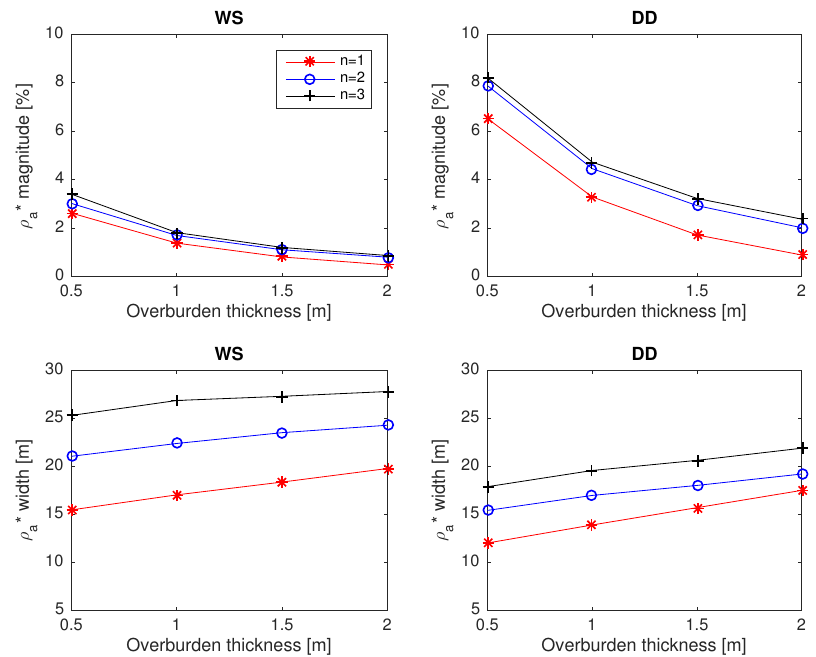
Figure 5. Apparent resistivity anomaly magnitude and width as a function of overburden thickness for the case of a single, 1-mm-aperture fracture having length (cid:96) = 5 m, electrical resistivity ρ f = 10 Ω · m, and dipping at 45 ◦ . The fracture is hosted in bedrock having resistivity ρ b = 10,000 Ω · m, whereas the overburden resistivity is ρ o = 1000 Ω · m. The measurement configuration is denoted by WS (Wenner-Schlumberger) or DD (dipole-dipole) with spacing factor n . Cases 2, 7, 8, and 9 from Table 1 are